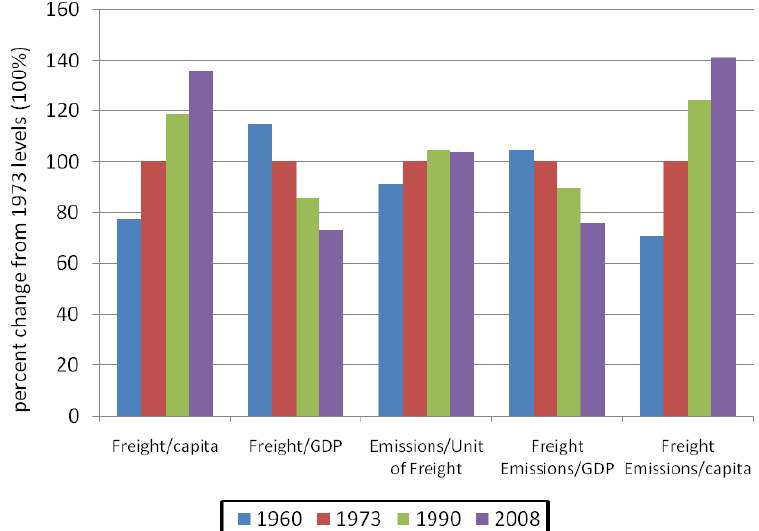
Figure 6. Summary of Emissions Changes from